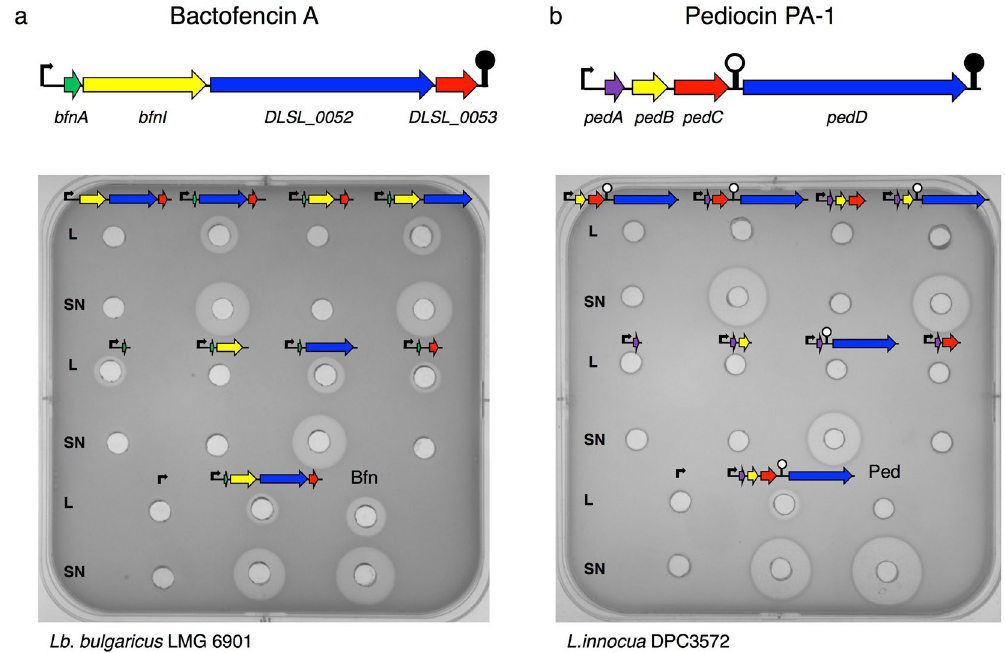
Figure 3. Antimicrobial activity of cell-free supernatants (SN) and lysates (L) of E . coli Tuner TM (DE3) after 3 hours of 25 µ M IPTG induction. ( a ) Analysis of bactofencin A activity against Lb . bulgaricus and ( b ) pediocin PA-1 activity againt L . innocua . The genes that encode the structural peptide of bactofencin and pediocin are indicated in green and purple arrows, respectively. The immunity, the transporter and the accessory protein encoded genes are shown in yellow, blue and red arrows. The black arrow indicates the T7 lac promoter. Samples from the natural producers Lb . salivarius DPC6502 and P . acidilactici LMG2351 are indicated as Bfn and Ped.